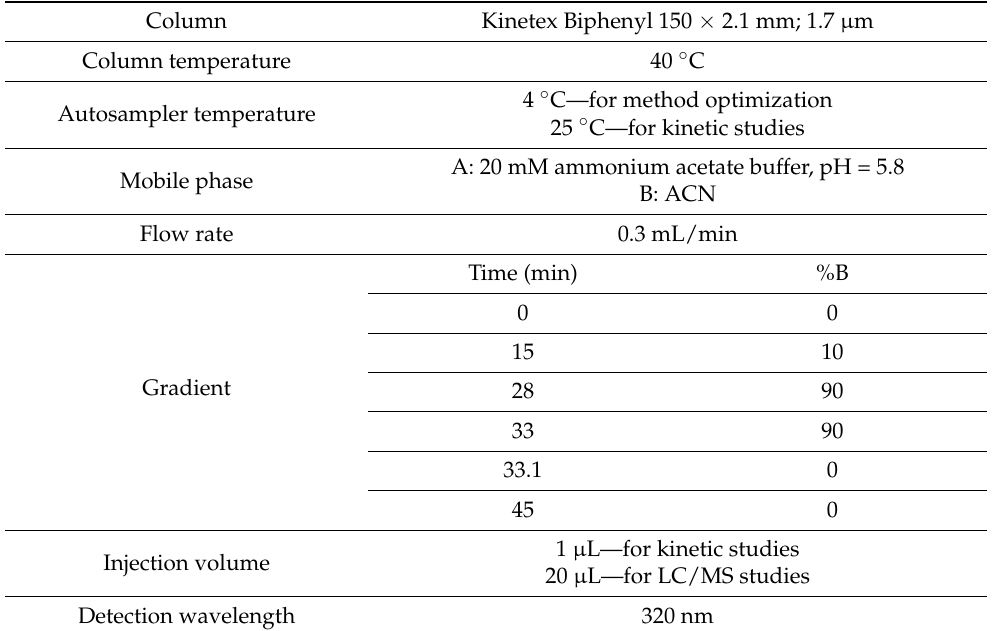
Table 1. The elaborated optimal chromatographic conditions for the separation of ceftobiprole and its related substances.